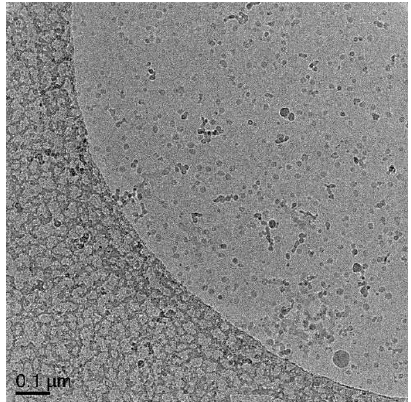
Figure 9. Cryo-TEM micrograph of Exp 2, polymerization of MA/EGDA with Oligo 1 without DODAB vesicle. Additional images in Figure S2.